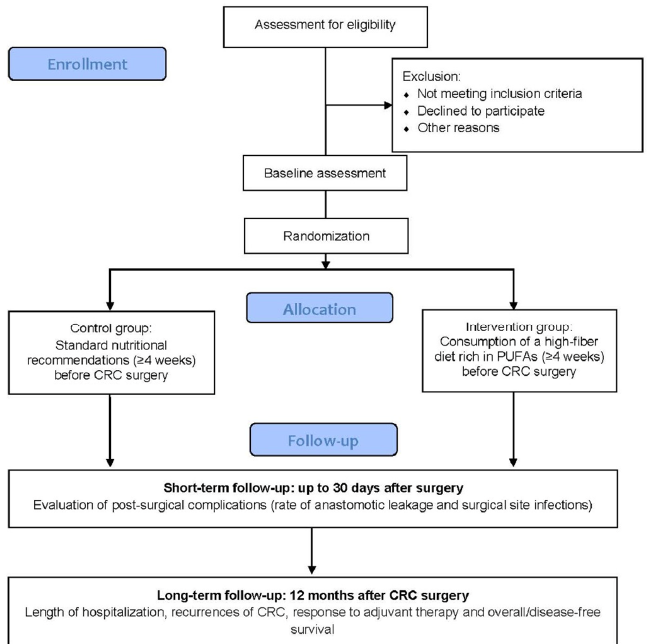
Figure 1. Trial flowchart of the intervention.